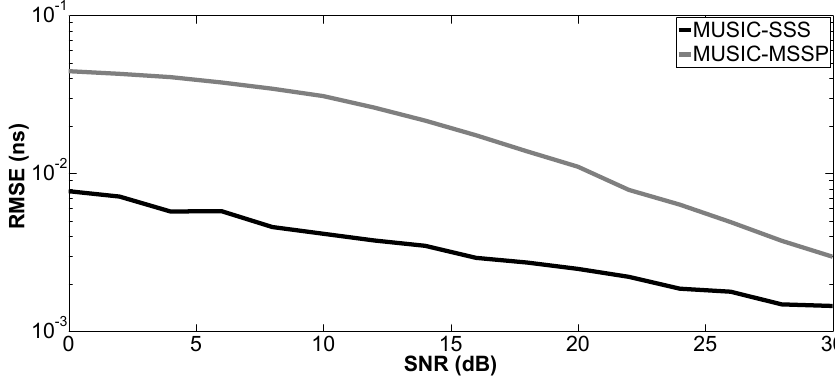
Figure 4. RMSE on the estimated time delay ˆ t 1 versus SNR.